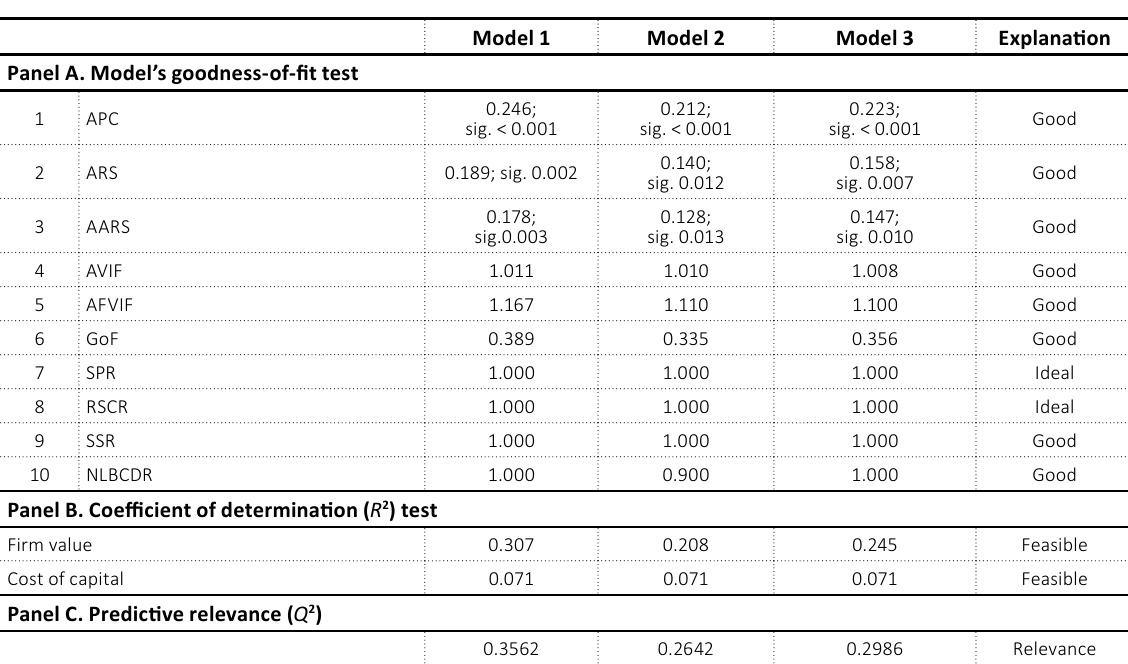
Table 4. Structural model analysis